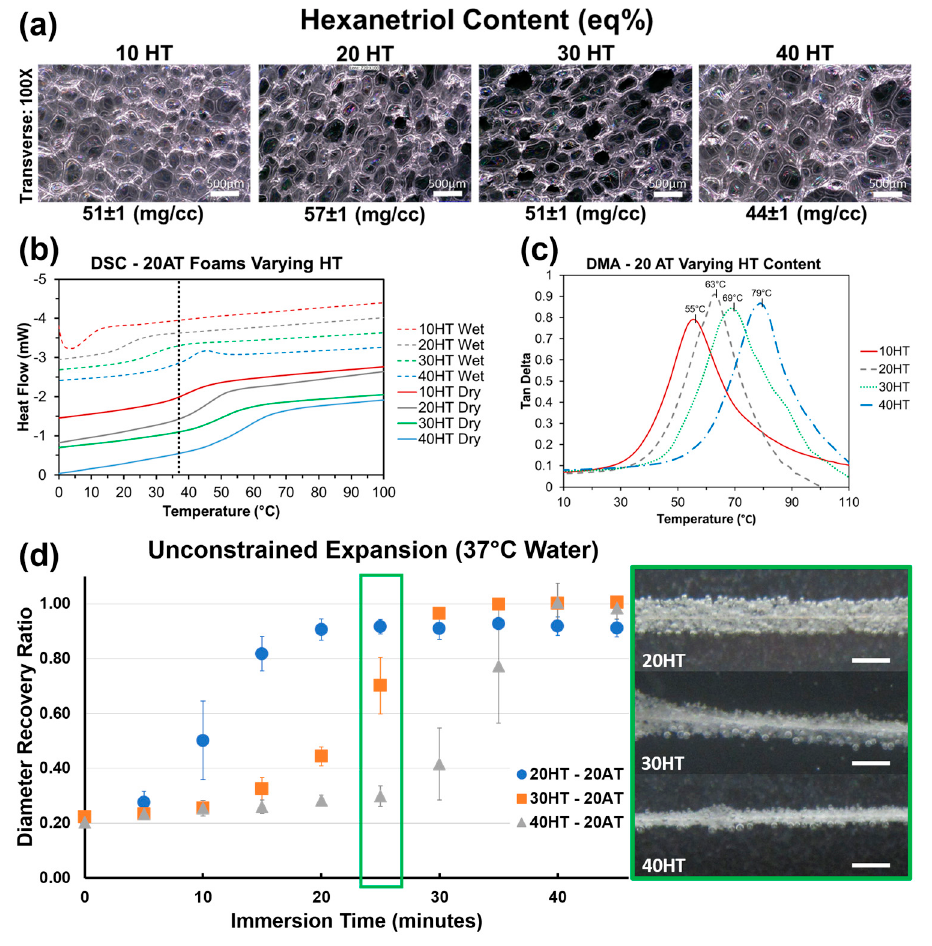
Figure 6. ( a ) Light microscopy images of 20% ATIPA foams with varying HT content at fixed density. ( b ) Differential scanning calorimetry (DSC) thermograms for the same foam series under wet and dry conditions. The dotted vertical line at 37 °C represents body temperature; ( c ) Compression DMA for the same foam series; ( d ) Unconstrained foam expansion profiles in a body temperature (37 °C) water bath. Scale bars are 1 mm.